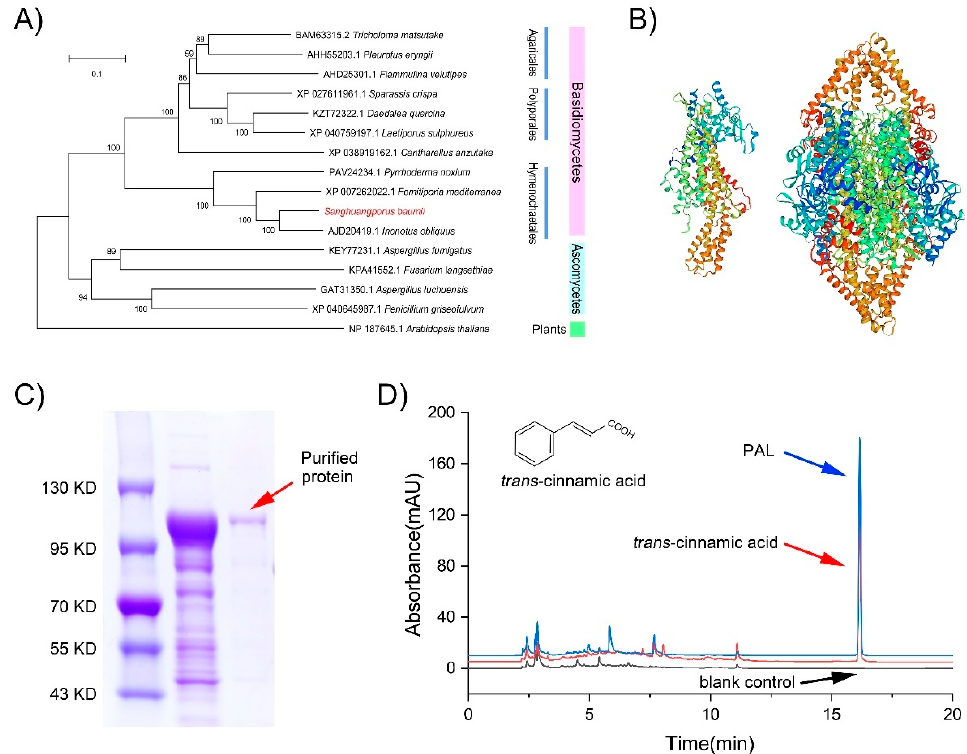
Figure 5. Functional analysis of Sb PAL. ( A ) Phylogenetic tree constructed based on the PAL sequences of S. baumii and 15 other species. ( B ) Predicted 3D structure of Sb PAL showing the monomer protein (left) and homo-tetrameric protein (right). ( C ) Recombinant His-tagged Sb PAL on the SDS-PAGE gel. ( D ) Determination of trans -cinnamic acid in reaction solution. The red, blue, and black peaks are standard trans -cinnamic acid, the reaction solution containing purified Sb PAL, and a blank control reaction solution, respectively.